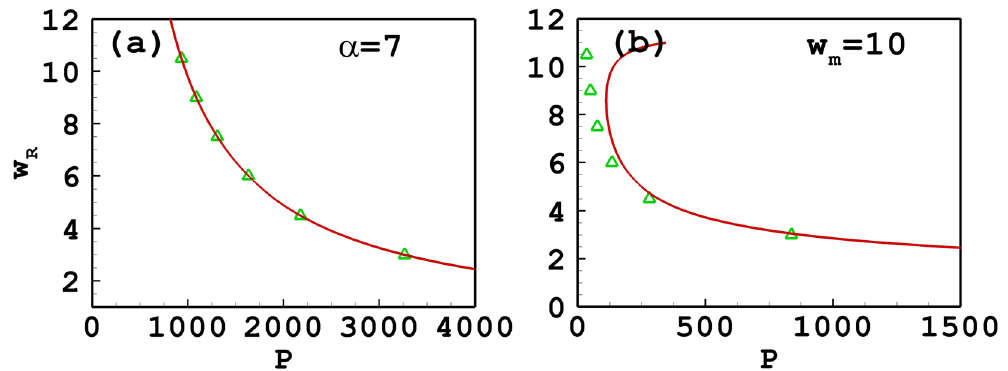
Figure 2. The soliton width versus the power of tripole-mode solitons. ( a ) The degree of nonlocality is fixed at α = 7; ( b ) the width of the response function is fixed at w m = 10. The solid line and the triangles denote, respectively, the approximate solutions and the numerical